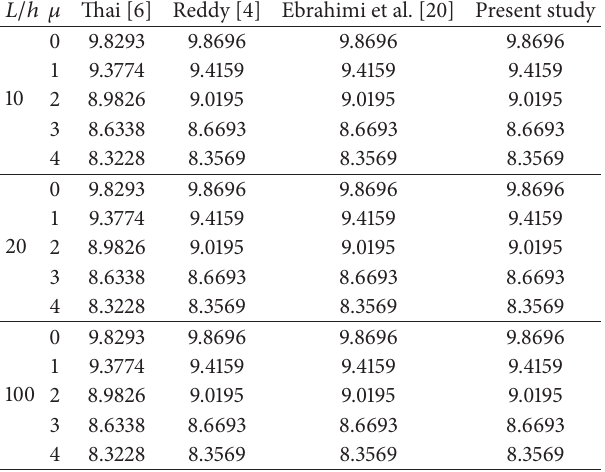
Table 1: Comparison of the dimensionless fundamental natural frequencies of simply supported nanobeam.